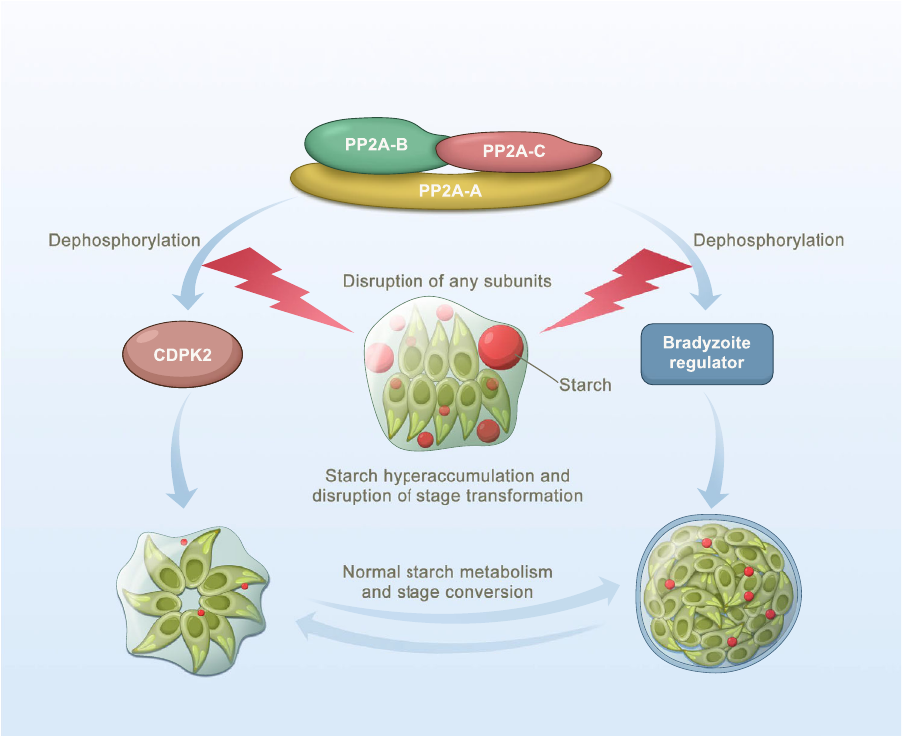
Fig. 9 | Schematic representation of the PP2A holoenzyme as an integral componentoftheregulatorynetworkmediatingamylopectinmetabolismand tachyzoite-to-bradyzoite transformation in Toxoplasma gondii . T. gondii PP2A holoenzyme consists of a scaffolding subunit PP2A-A, a catalytic subunit